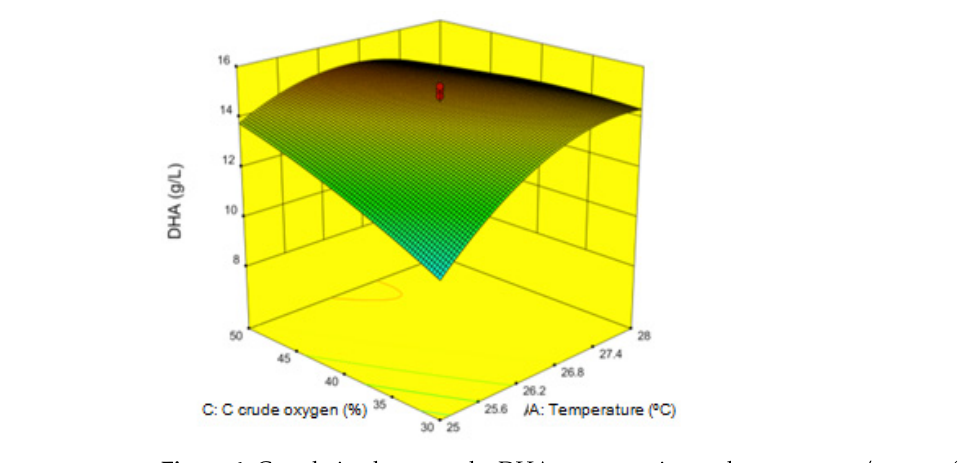
Figure 4. Correlation between the DHA concentration and temperature/oxygen (red points indicate the maximum DHA values).